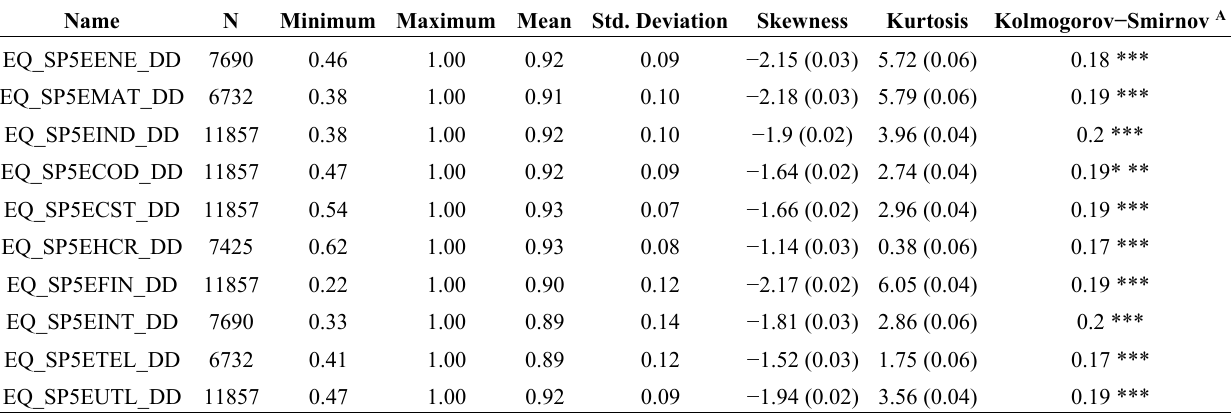
Table 2. Descriptive statistics and normality testing for raw stress